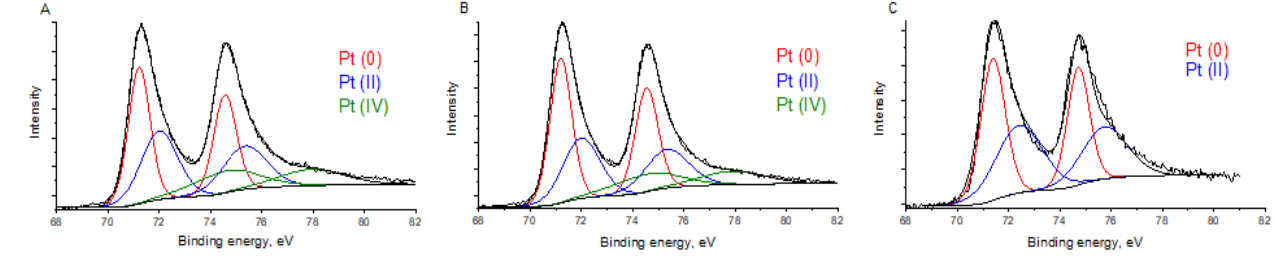
Figure 4. Spectra Pt 4f of Pt 20 /rGO ( A ), Pt 20 /rGO-O ( B ) and Pt 20 /rGO-Am ( C ) catalysts obtained by the XPS method.